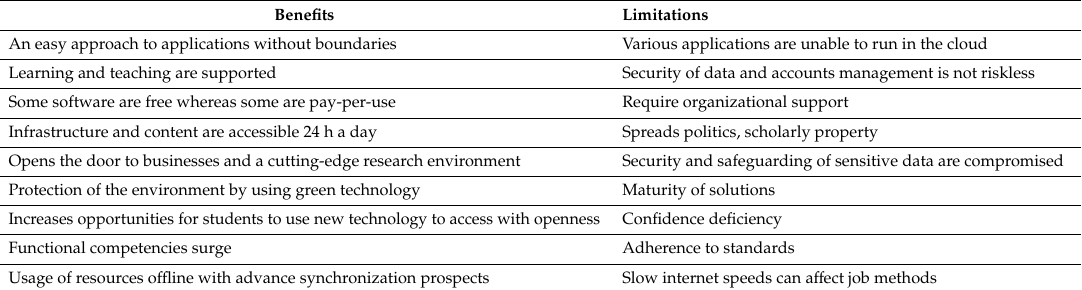
Table 1. Pros and cons of a cloud strategy in higher